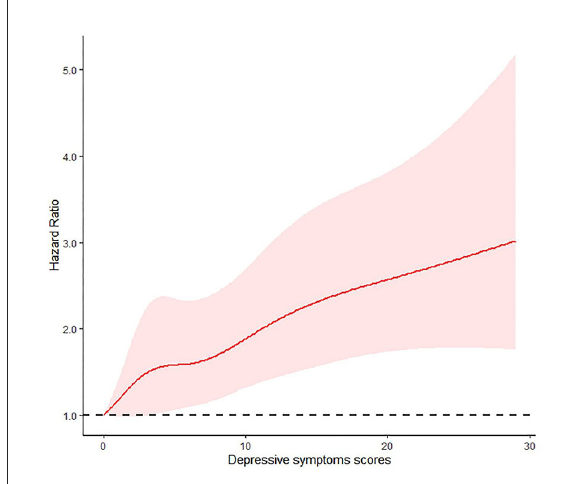
FIGURE1 Adjusted Hazard Ratios (HRs) of depressive symptoms scores on ADL disability. Results from the restricted cubic spline Cox proportional hazards regression model.